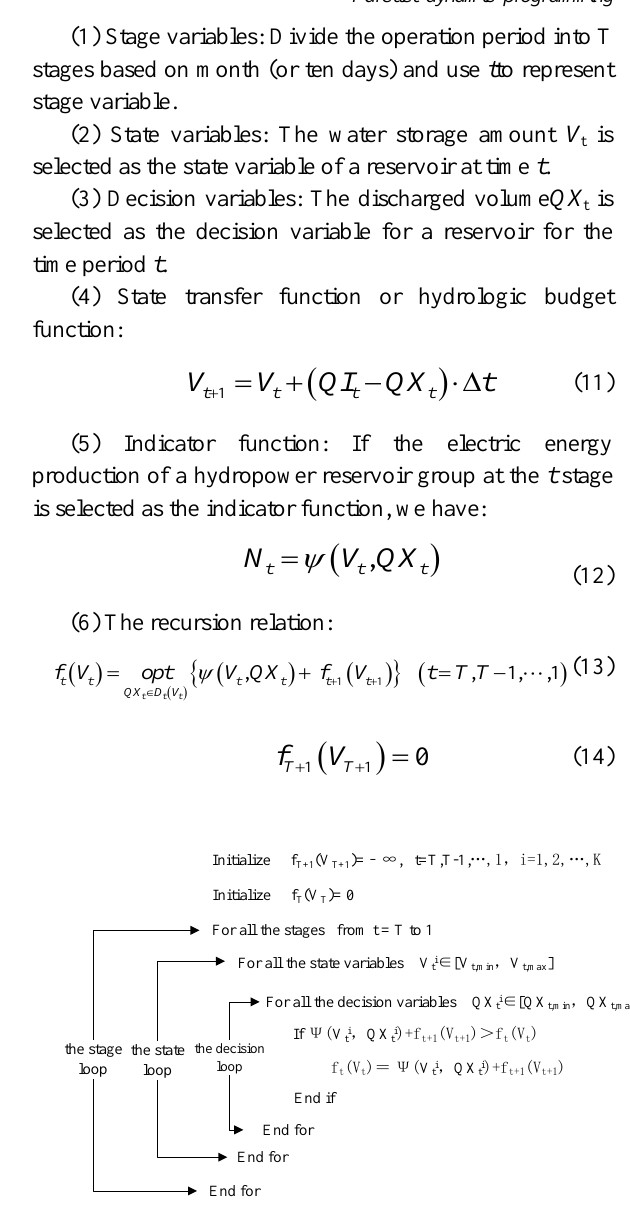
Fig. 1. The pseudo-codes for a serial DP recursive